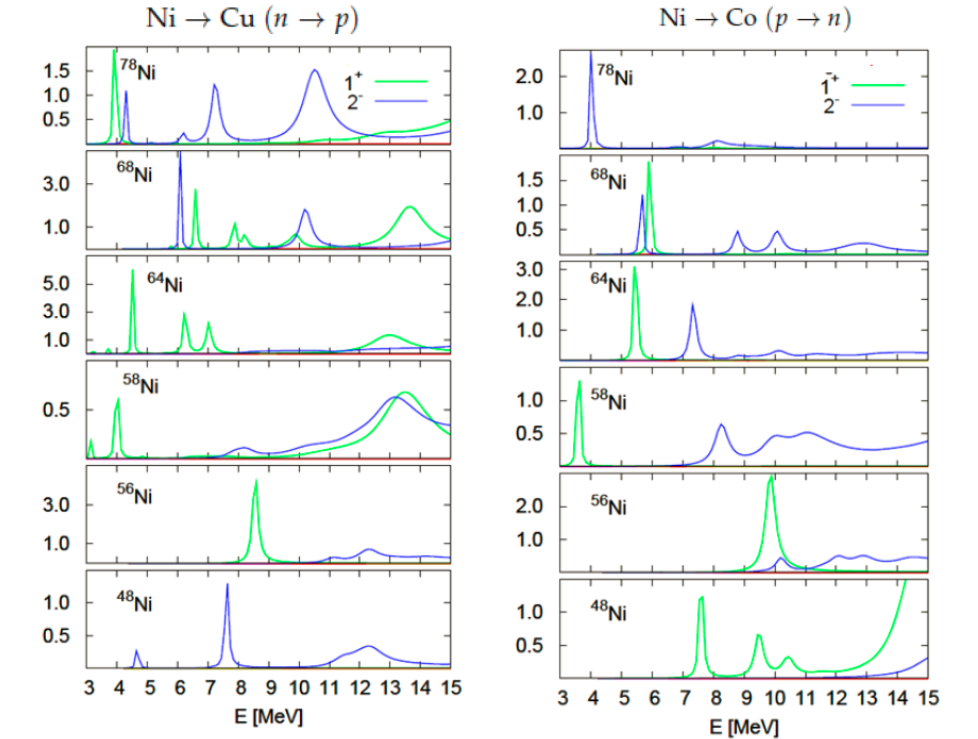
Figure 3. (Color online) QRPA multipole response functions for charge exchange excitations of the Ni isotopes. Gamow-Teller type spin-isospin flip p − 1 n and n − 1 p excitations of multiparity 1 + and 2 − are shown in the left and the right panel, respectively.